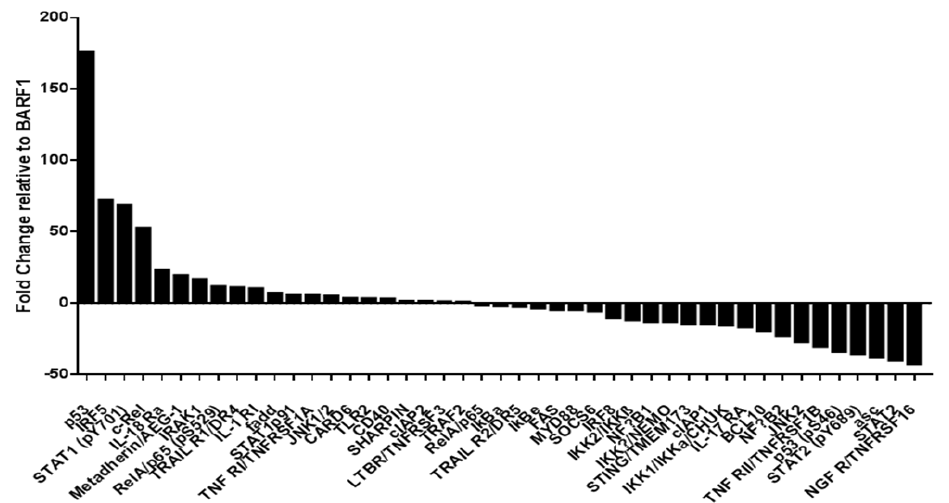
Figure 4. Protein array for NF- κ B signaling pathway activation in SiHa cells. Activation of NF- κ B signaling pathway was compared between SiHa cells transfected with BARF1 or empty vector. Data were presented in reference to the fold-change occurring in the presence of BARF1 compared to the empty vector control.